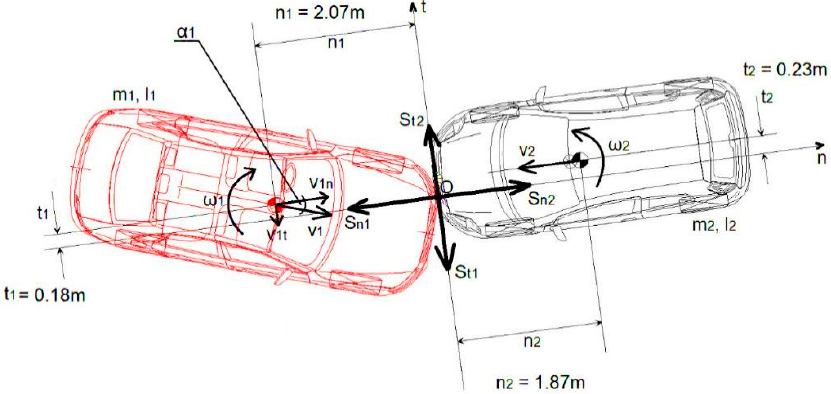
Figure 5. The mutual location of both vehicles at the beginning of the collision with the positive directions marked.